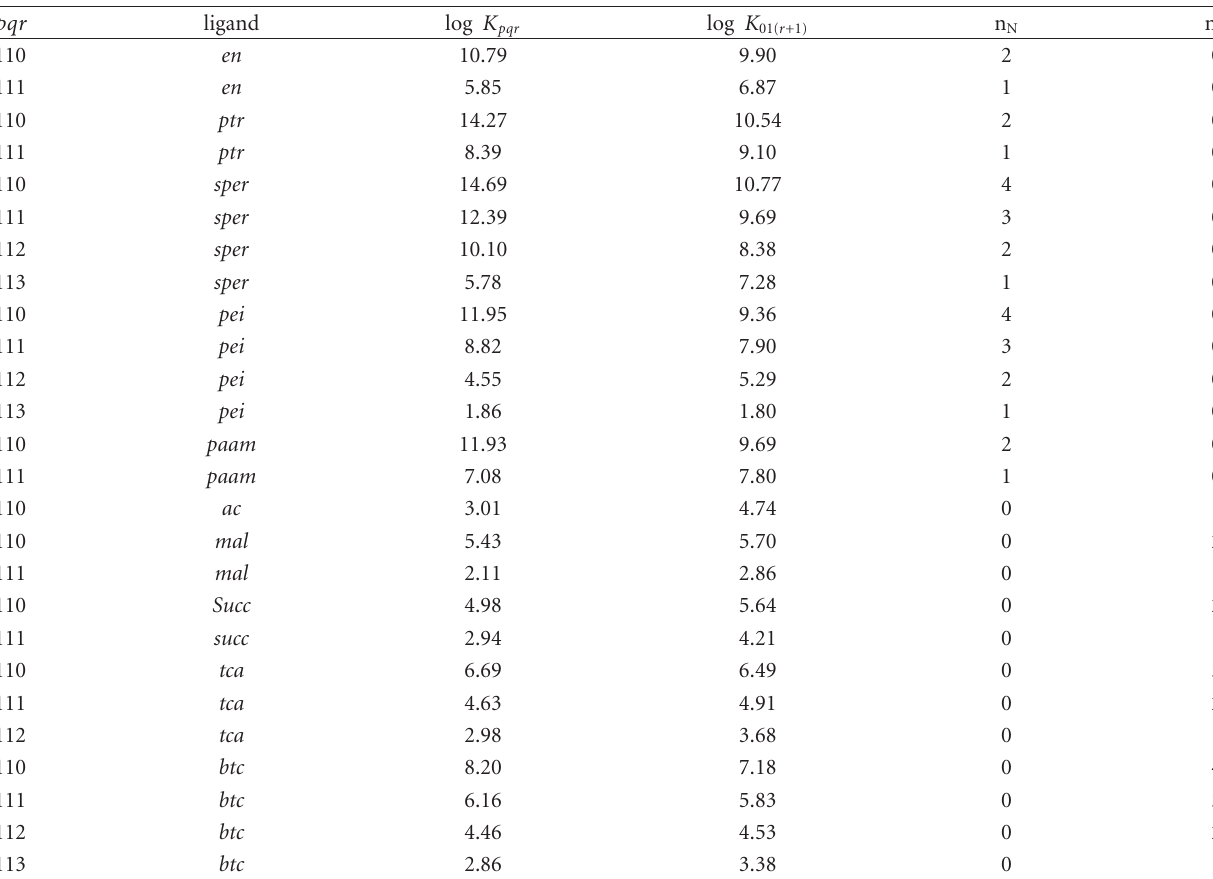
Table 11: Dataset of protonation, complex formation constants and number of functional groups involved in the complex formation reaction for dmt /amine and dmt /carboxylate species, at t = 25 ◦ C and infinite dilution, used to derive parameters of (16) and (17).